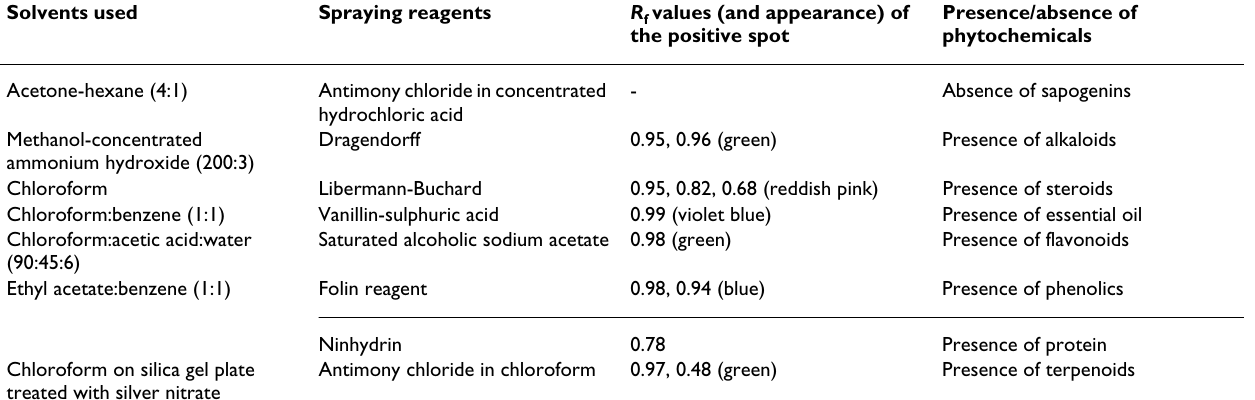
Table 5: Phytochemical analysis of the chloroform:methanol extract of the green berries of S. villosum Solvents used